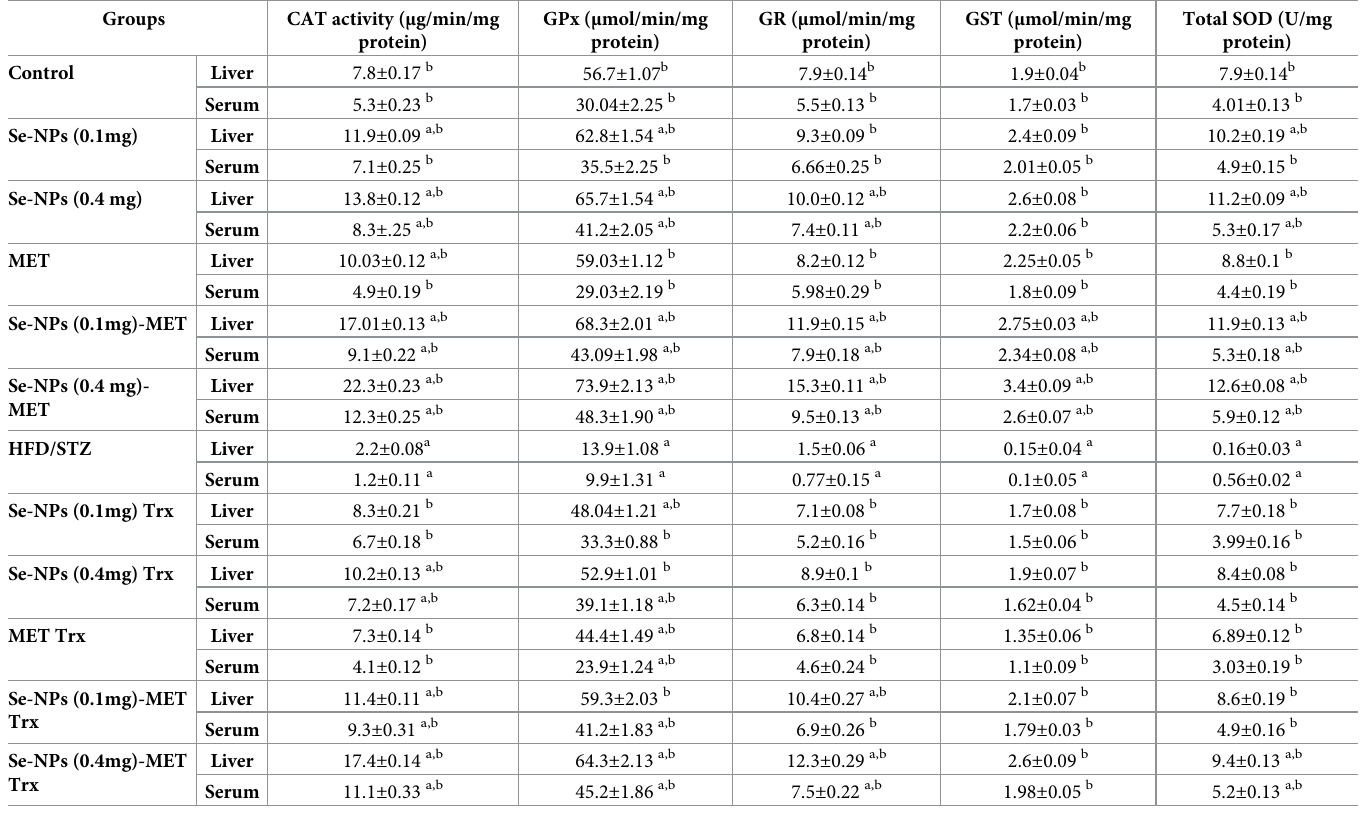
Table 7. Evaluation of the antioxidant enzyme variations (Total-SOD, CAT, GPx, GR, and GST) in serum and liver tissue of HFD/STZ-induced rats and after treat- ment with Se-NPs, MET monotherapy, and combined therapy. Groups